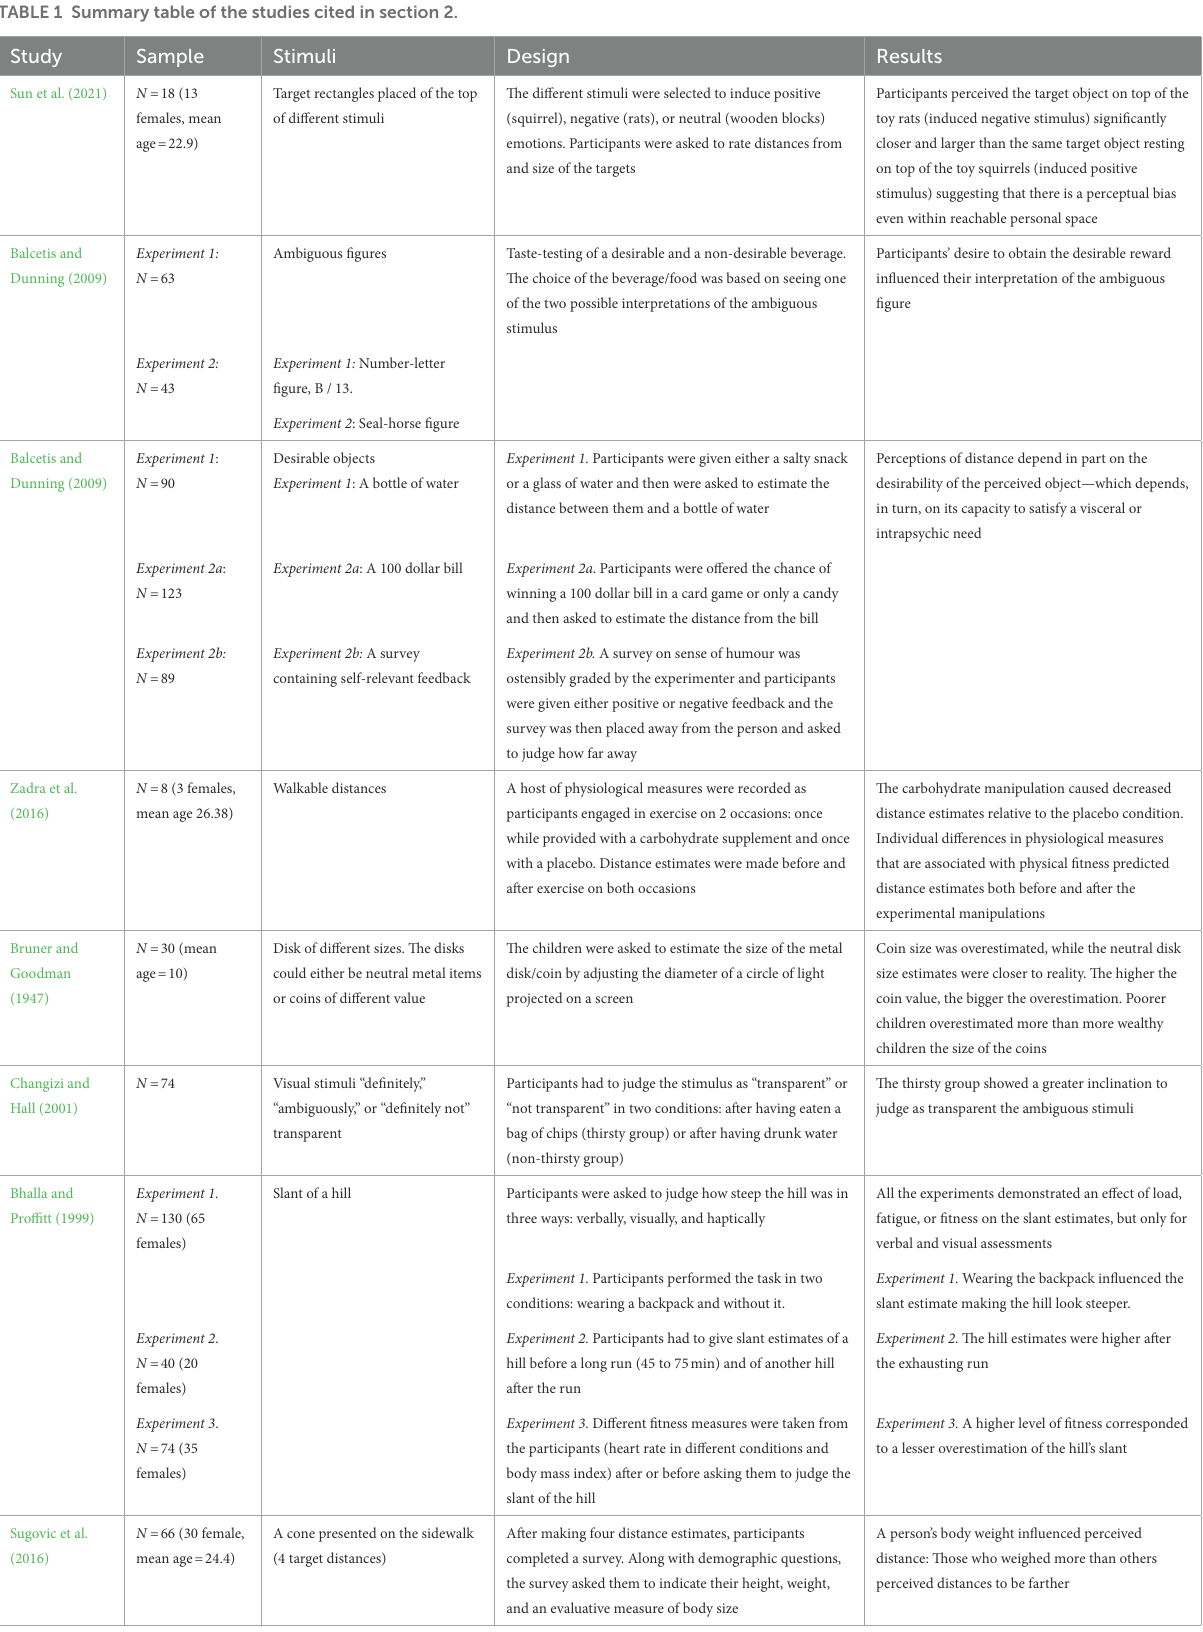
TABLE 1 Summary table of the studies cited in section 2.